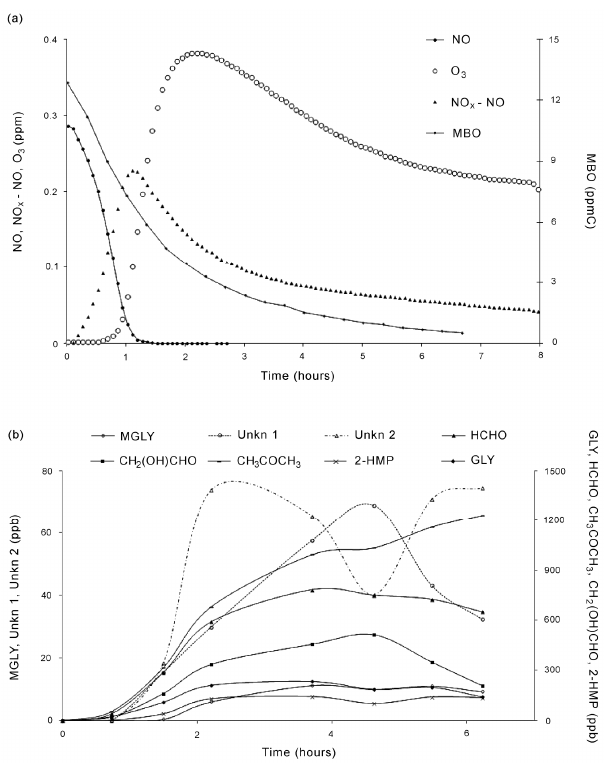
Fig. 1. Time profiles of gas-phase oxidation products from the oxidation of MBO. (a) Experiment ER-463 and (b) experiment ER-467.